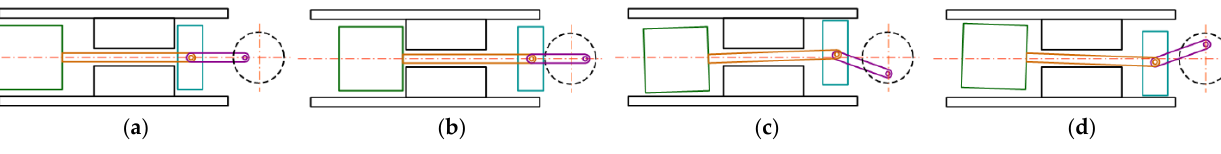
Figure 3. Parallel offset motion of piston rod under reciprocating. ( a ) TDC; ( b ) BDC; ( c , d ) Parallel offset motion.